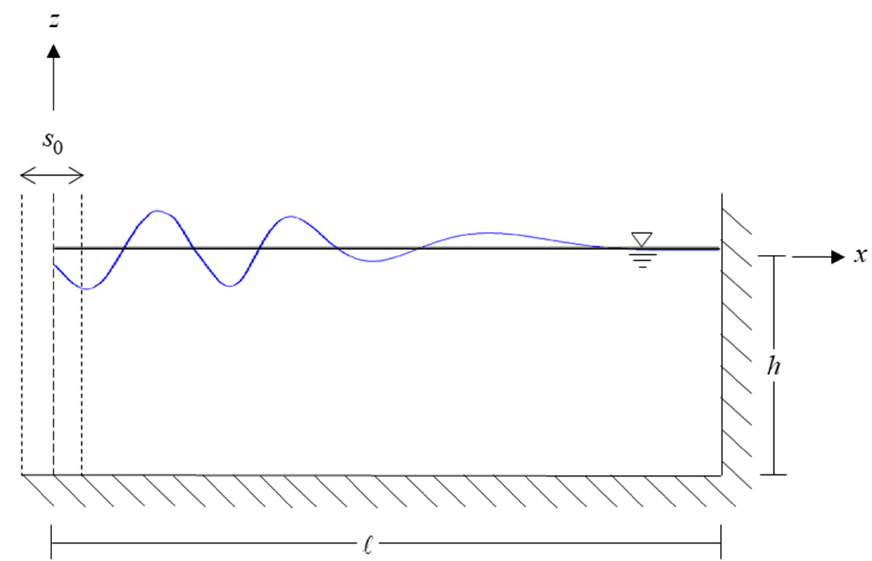
Figure 1. Definition sketch of the wavemaker problem in a channel.